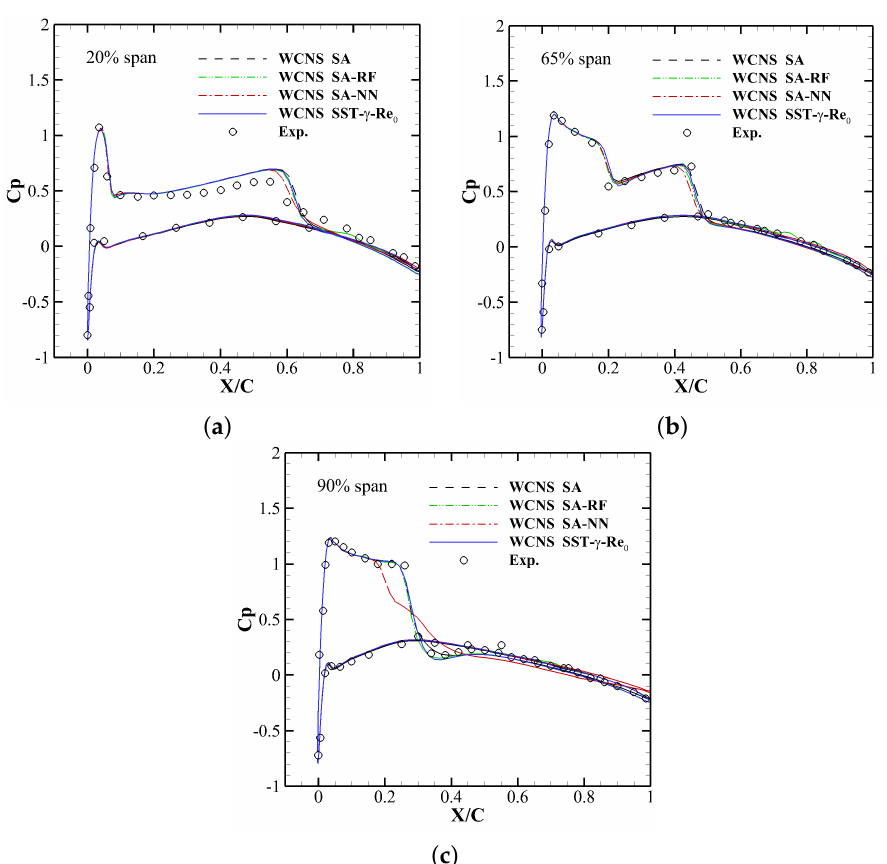
Figure 22. Surface pressure coefficient of ONERA M6 3D airfoil. ( a ) 65% span. ( b ) 90% span. ( c ) 95%